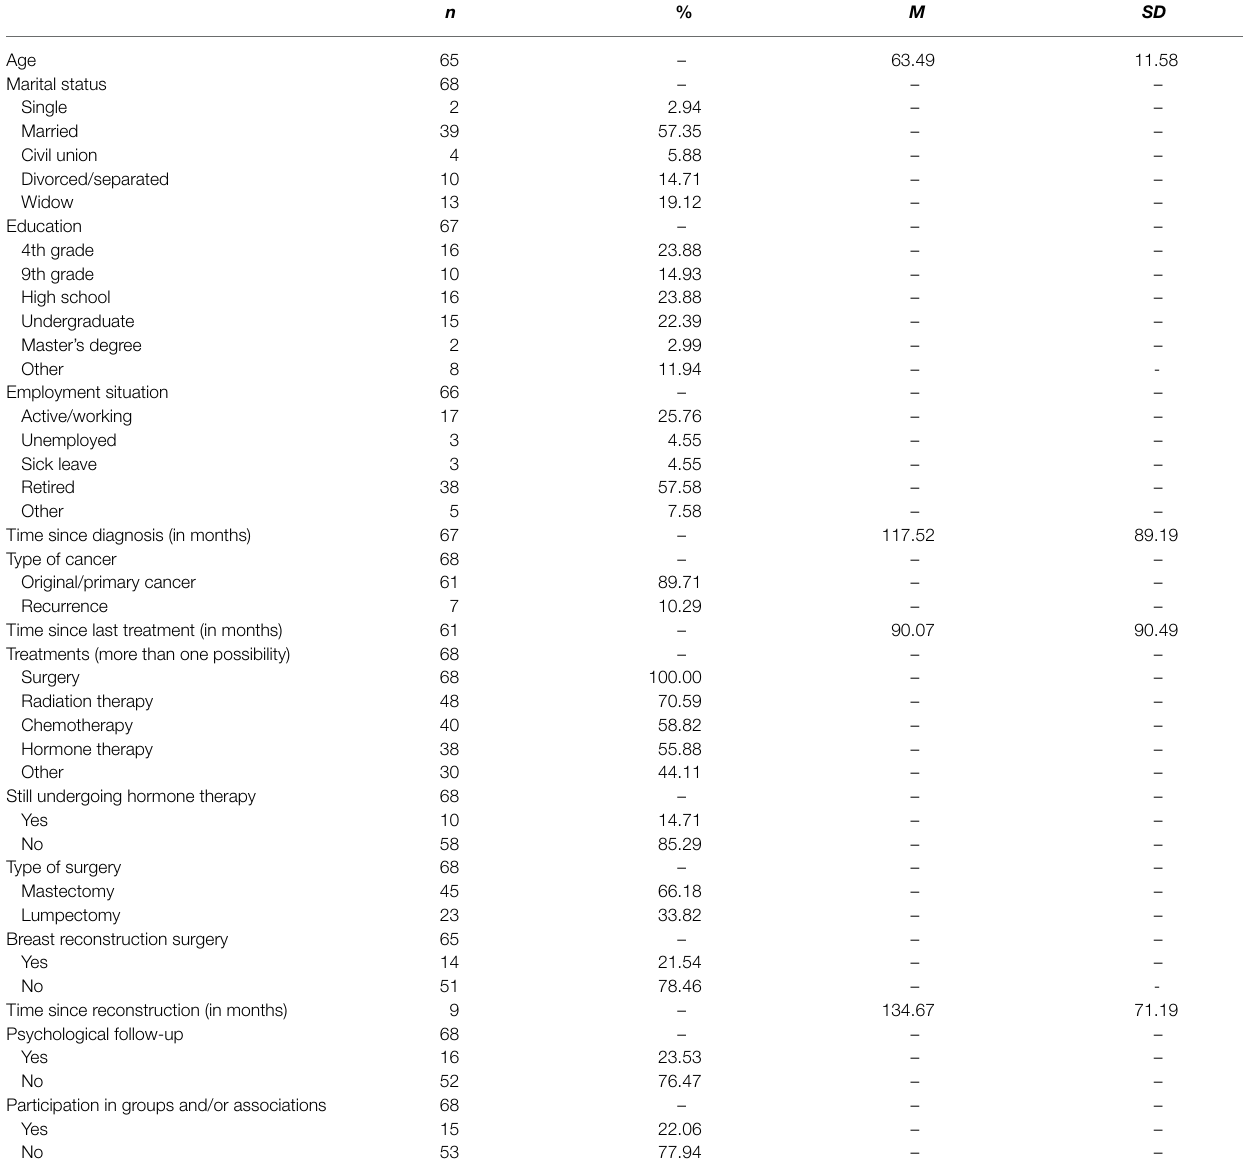
TABLE 1 | Sociodemographic and clinical characteristics of the